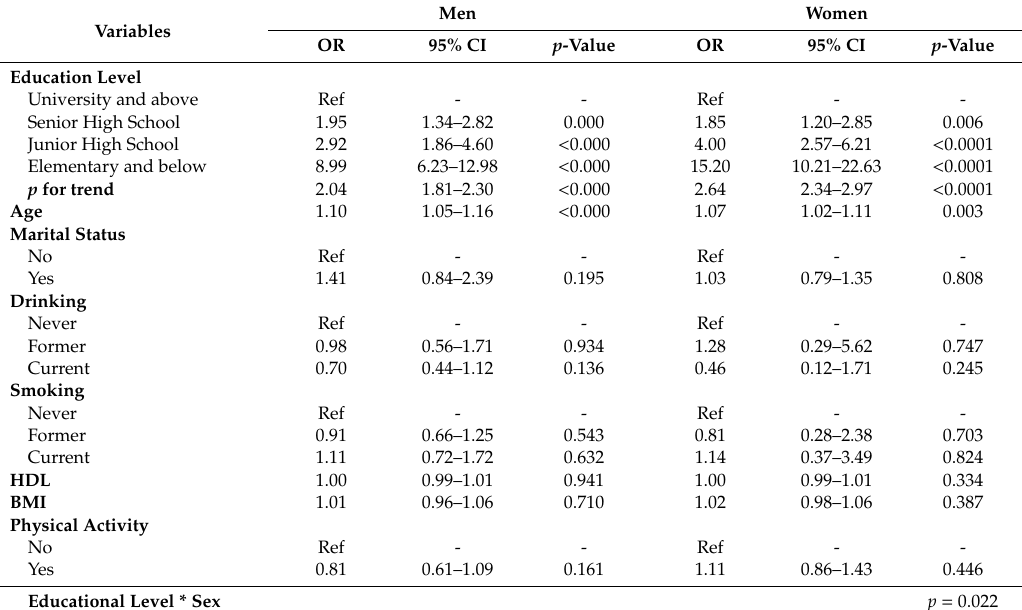
Table 3. Multivariate logistic regression analysis showing associations with Mini-Mental State Examination (MMSE) scores stratified by sex.